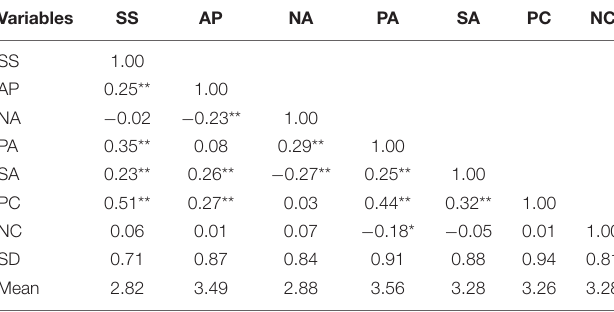
TABLE 2 | Matrix table of correlation coefficient of various variables.